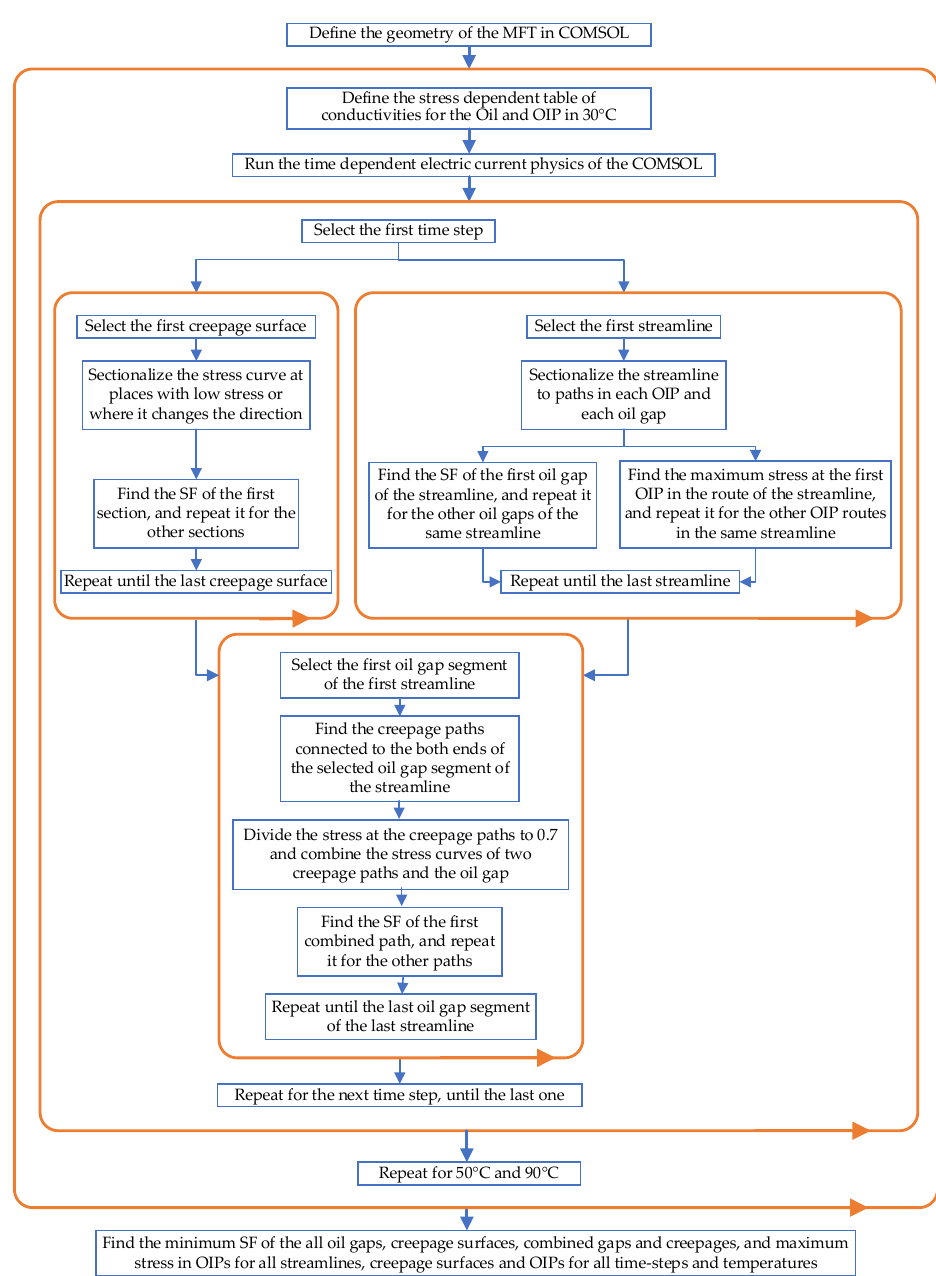
Figure 15. The flowchart of automatic insulation design evaluation applied in COMSOL Live Link with MATLAB.